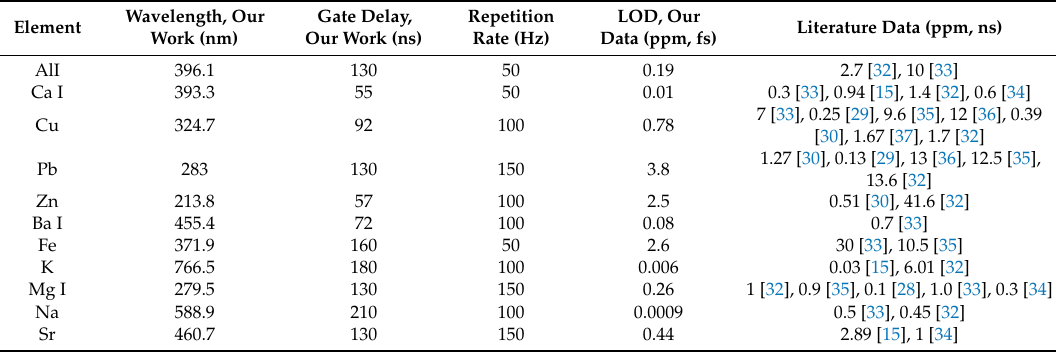
Table 2. LoD values for trace amounts of chemical elements in